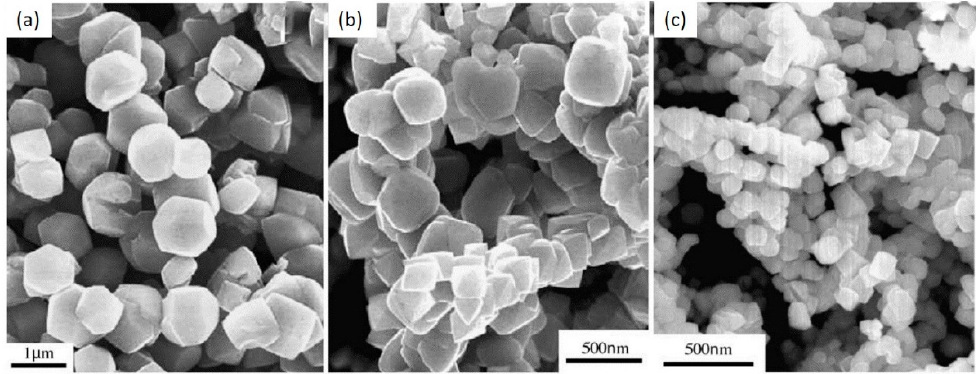
Figure 4. SEM image of ZnGa 2 O 4 crystals with different pH values ( a ) pH = 12, ( b ) pH = 10, ( c ) pH = 8 [67] (with copyright permission from Elsevier, 2020).